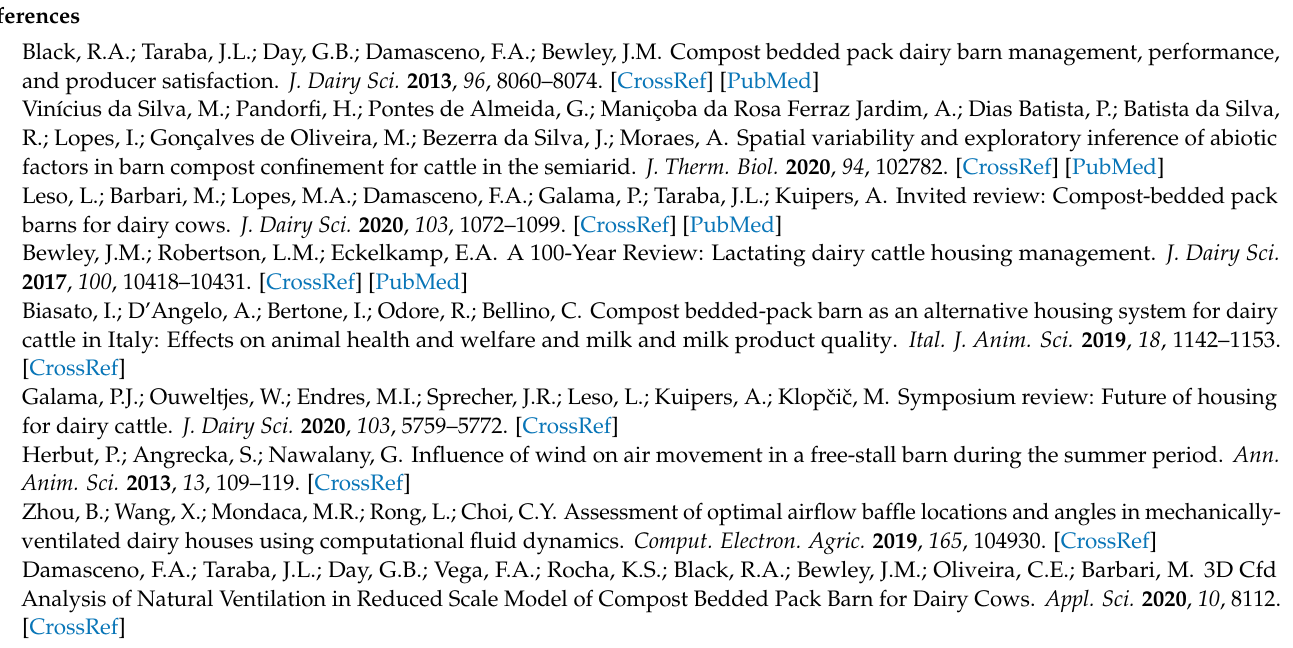
Figure A2. Examples of thermal images of the tunnel-ventilated compost-bedded pack barn analyzed. ( a )—Compost-bedded pack. ( b )—Drive-through feed alley. ( c )—Feed alley. ( d , e )—Exterior. ( f )—False ceiling. ( g )— Lateral curtain. ( h )—Exhaust fans wall. ( i )—Cooling